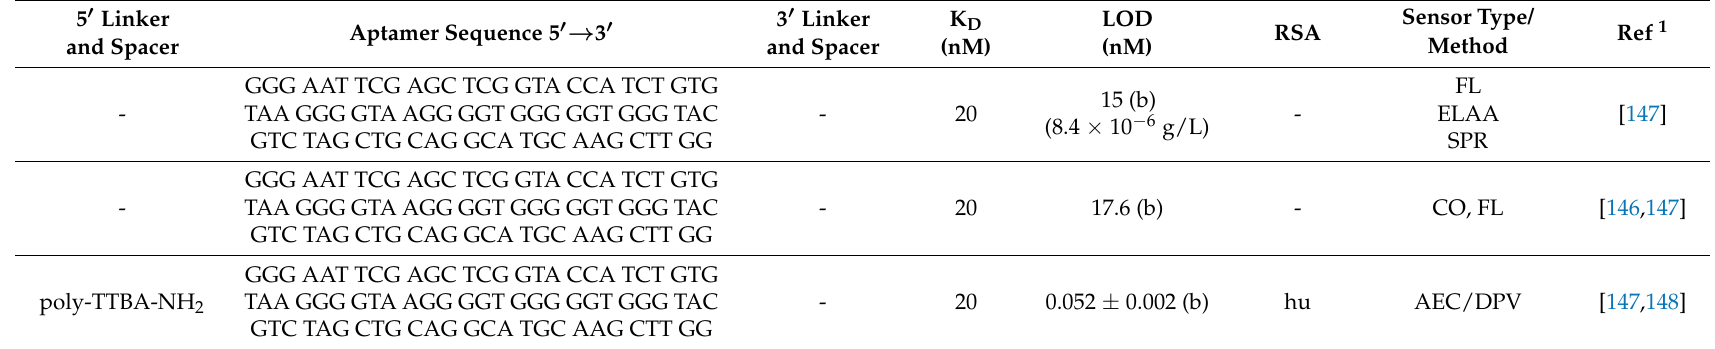
Table 8. Aptamer sequence, dissociation constant (K D ), limit of detection (LOD), real sample analysis (RSA), and realized sensor type and measuring method daunomycin in the corresponding references (Ref). AEC = amperometric electrochemical, b = buffer, CO = colorimetric, DPV = differential pulse voltammetry, ELAA = enzyme-linked aptamer assay, FL = fluorometric, hu = human urine, and SPR = surface plasmon